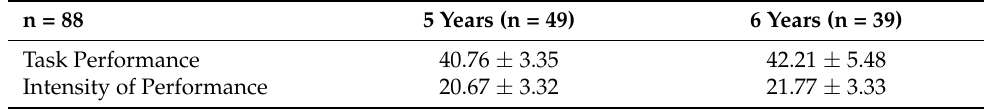
Table 3. Task and intensity performance results by age.